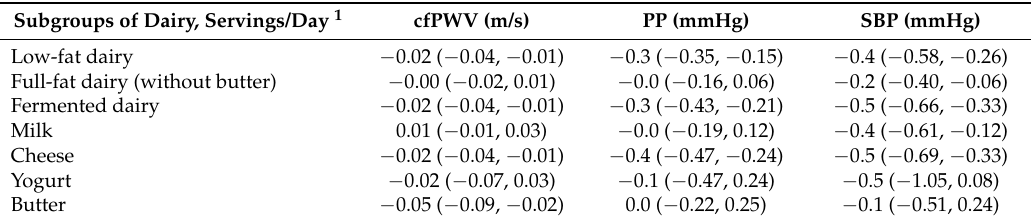
Table 4. Adjusted differences in cfPWV, PP and SBP associated with a 1 serving/day increase in the intake of dairy products: ELSA-Brasil, 2008–2010 1 .